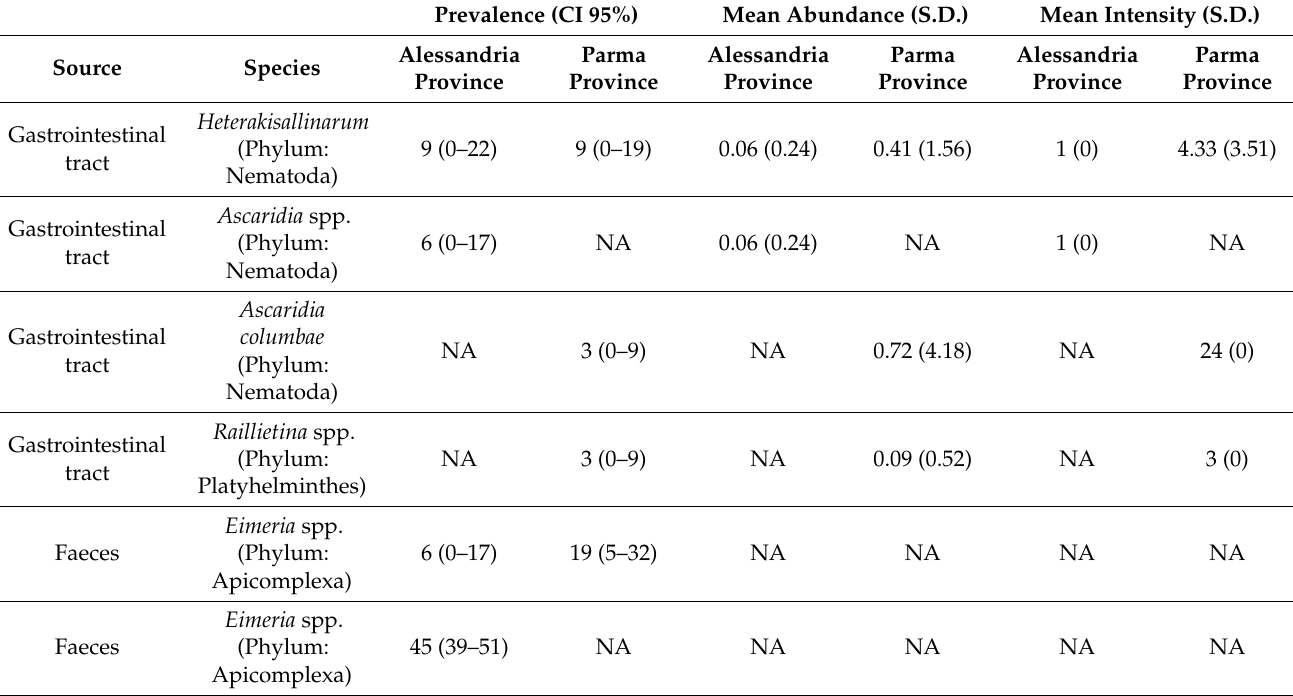
Table 1. Gastrointestinal parasite species from Red-legged partridge in Italy. Alessandria province: 18 animals and 229 fecal samples; Parma province 34 animals. Prevalence (CI 95%) Mean Abundance (S.D.) Mean Intensity